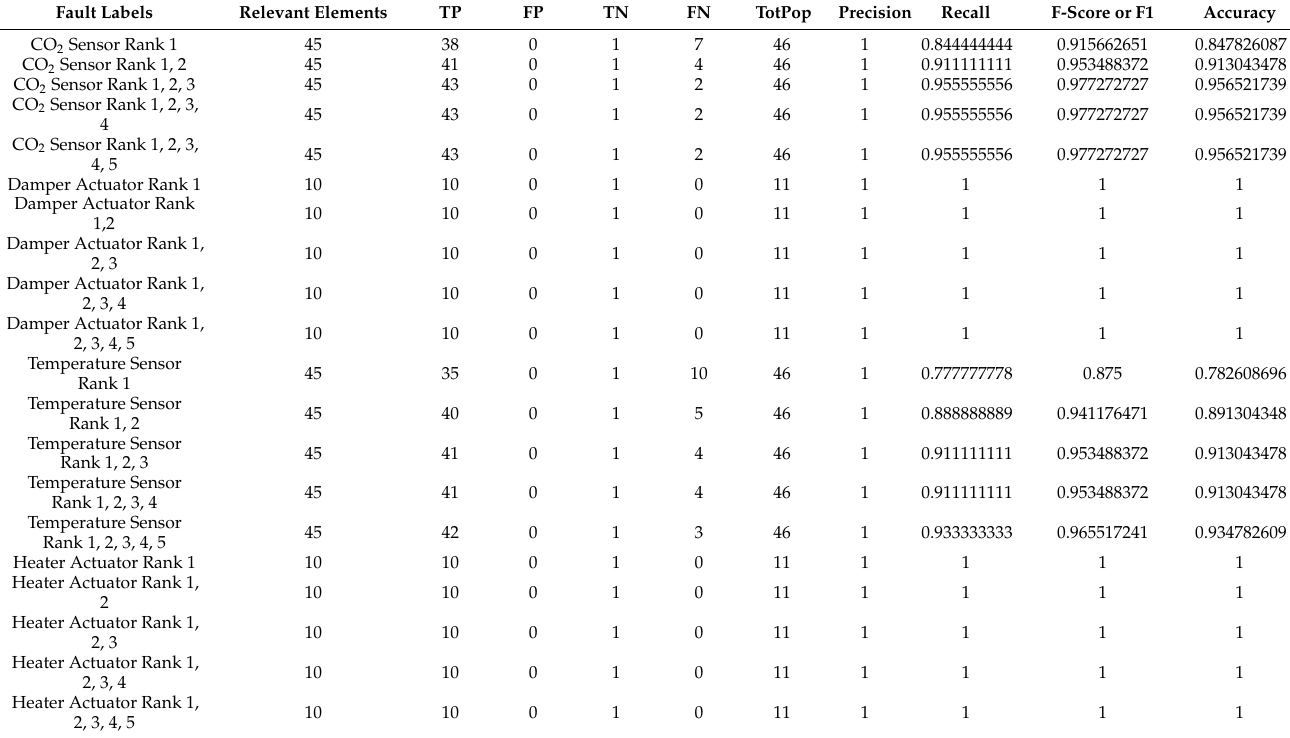
Table 28. Overview of performance metrics for the diagnostic method based on causal relations in FBBNs using RDPs.